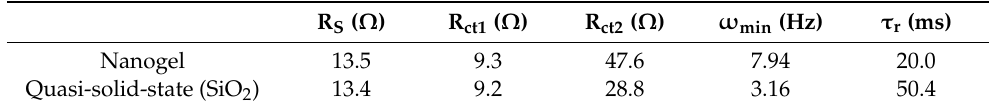
Table 2. Electrochemical parameters of DSSCs based on nanogel and quasi-solid-state (SiO 2 ) elec- trolytes obtained by fitting the Nyquist and Bode plots of EIS measurements.